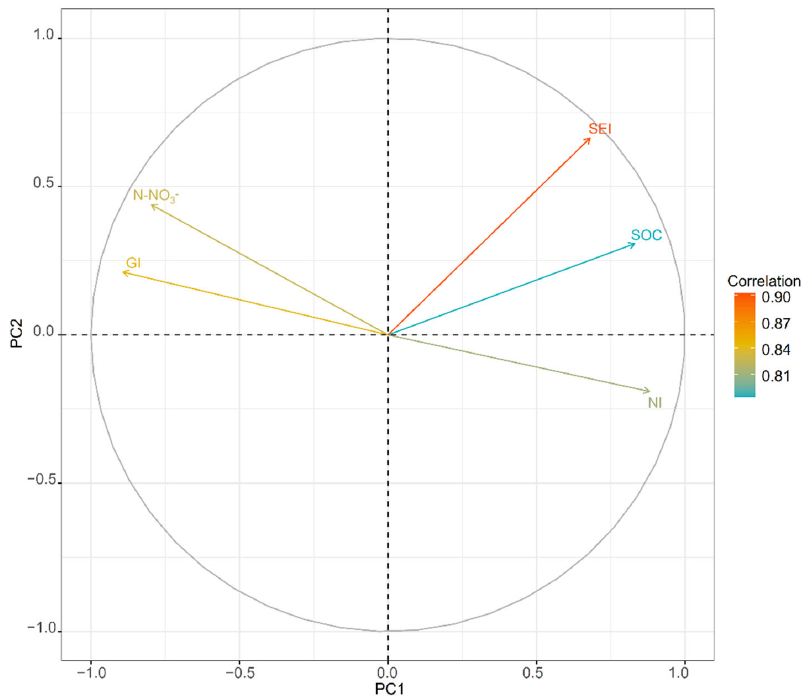
Figure 9. Bi ‐ graphic indicators and PCs. Figure 9. Bi-graphic indicators and